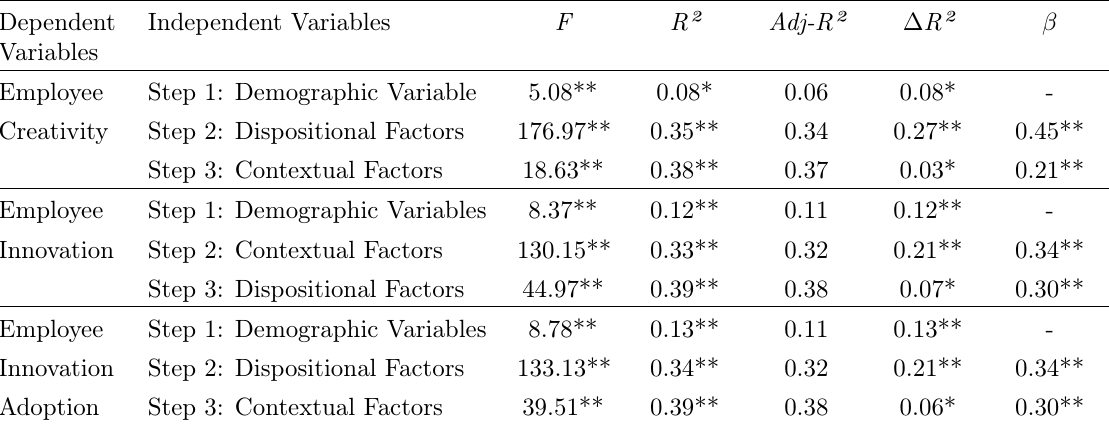
Table 3. Hierarchical Regression Analyses of Causal Effects of Dispositional and Contextual Factors on Employee Creativity, Innovation and Innovation